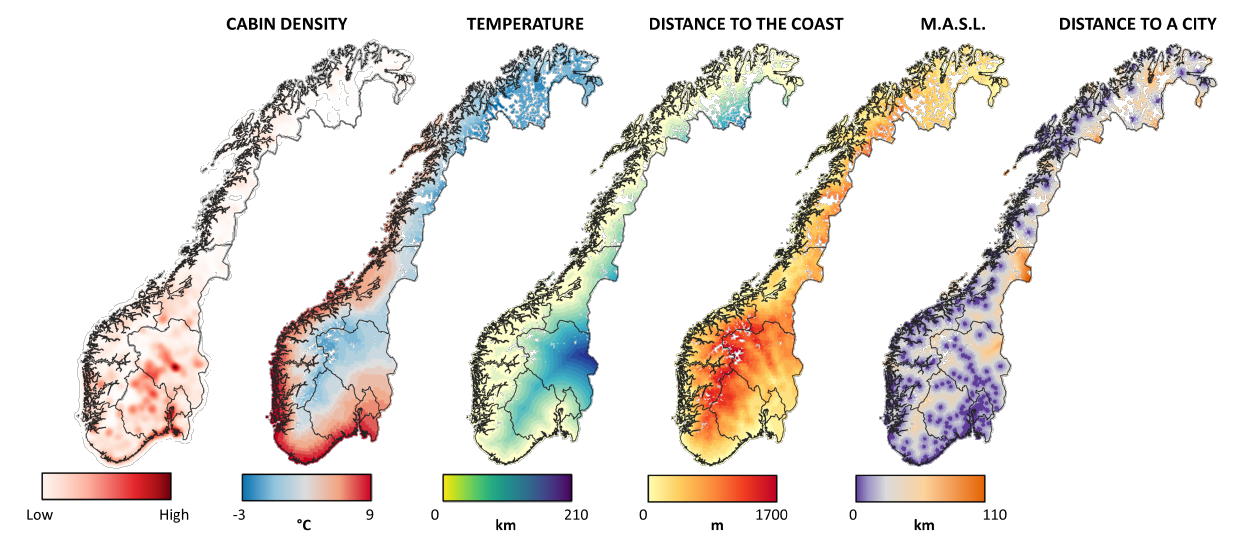
Figure 3. Properties assigned for cabin classification. From left to right; cabin density as heatmap, darker colors represent higher density. Temperature: the annual average temperature (2 m). Distance to the coast: the distance is calculated as the shortest straight-line from the cabin grid to the